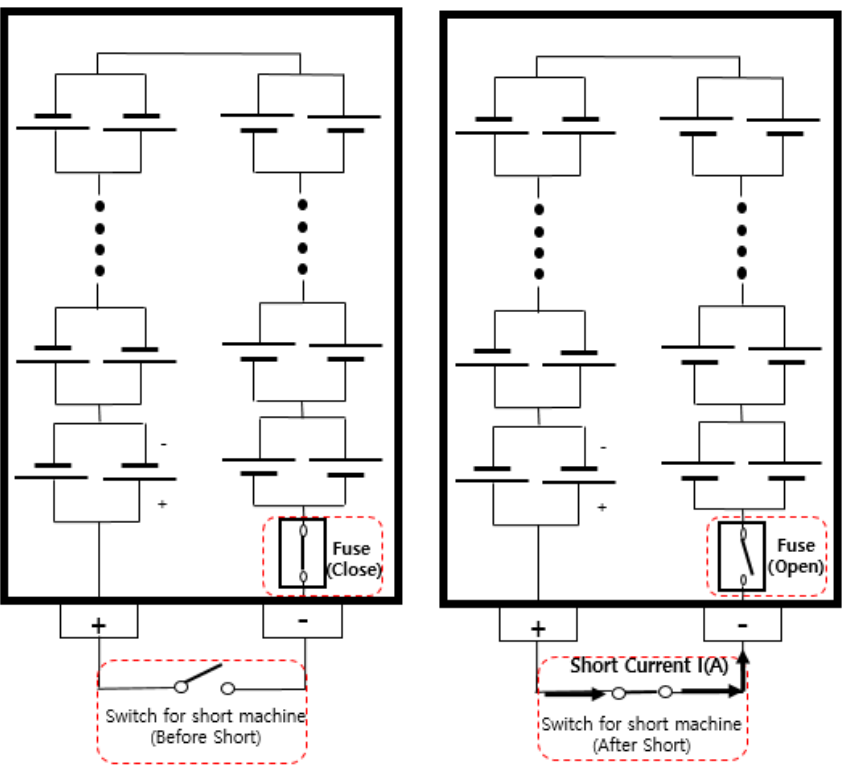
Figure 5. Operation diagram of battery module fuse by external short circuit.